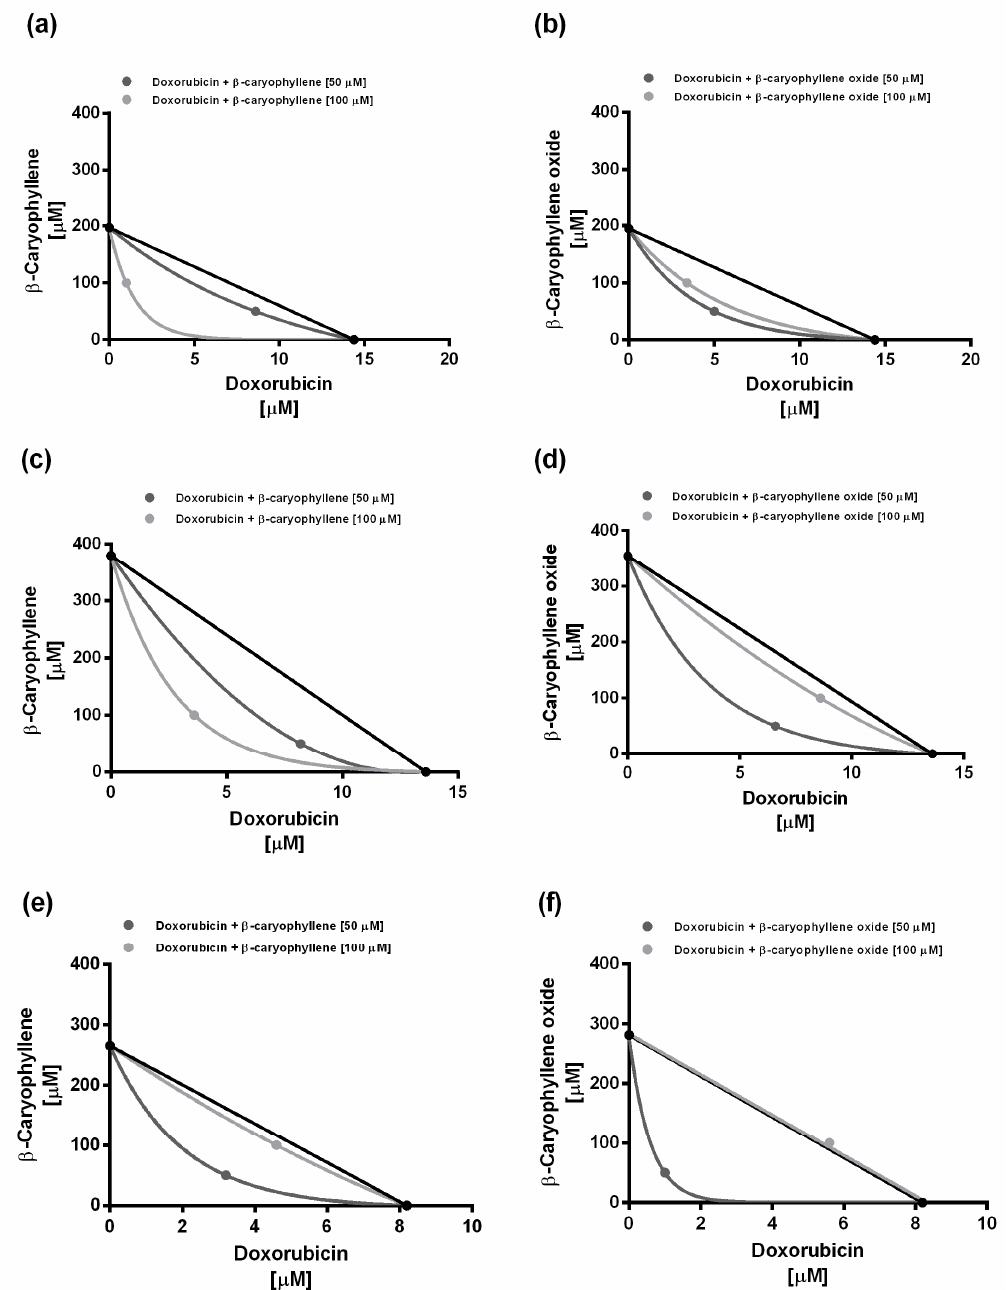
Figure 4. Isobolographic analysis of the cytotoxic effect obtained with the combination of doxorubicin and β -caryophyllene or β -caryophyllene oxide at the chemosensitizing concentrations of 50 and 100 µ M in HepG2 cells. ( a , b ) Long-term exposure of 24 h. ( c , d ) Short exposure of 2 h. ( e , f ) Double exposure of 2 h.